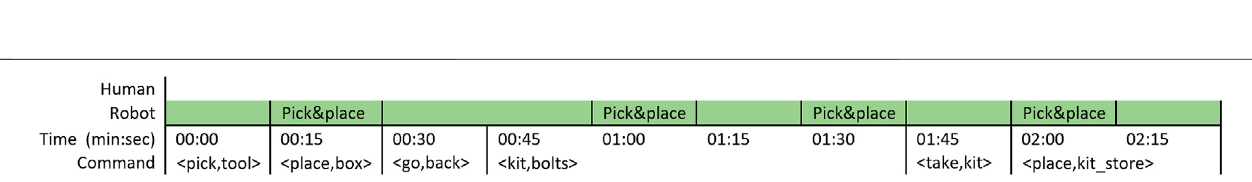
FIGURE 5 | Different stages of the kitting scenario by graphical command-based coordination. Left: 00:00 - commands < pick,tool > and < place,box > are send, which instructs the robot to pick and place the tool from the table to the kit. Second left: 01:00 - command < kit,bolts > is used to instruct the robot to place all bolts from the table into the kit. Second right: 02:00 - command < take,kit > is used to instruct the robot to pick up the kit from the table. Right: 02:15 - command < place,kit_store > is used to instruct the robot to place the kit on the other table.